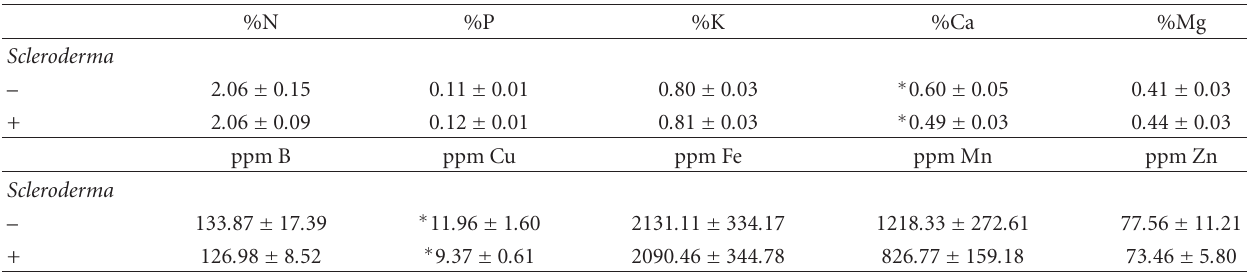
Table 4: Nutrient and metal concentration ( ± 1 SE) from a subsample of seedling leaf tissue between chestnuts colonized by Scleroderma (+) to those found without (–) sampled 18 months after planting ( n = 26). Asterisk ( ∗ ) indicates significant di ff erences. ECM plants had significantly lower Ca (%) and Cu (ppm). Analyses based on data transformation by Log ( n + 1). %N %P %K %Ca